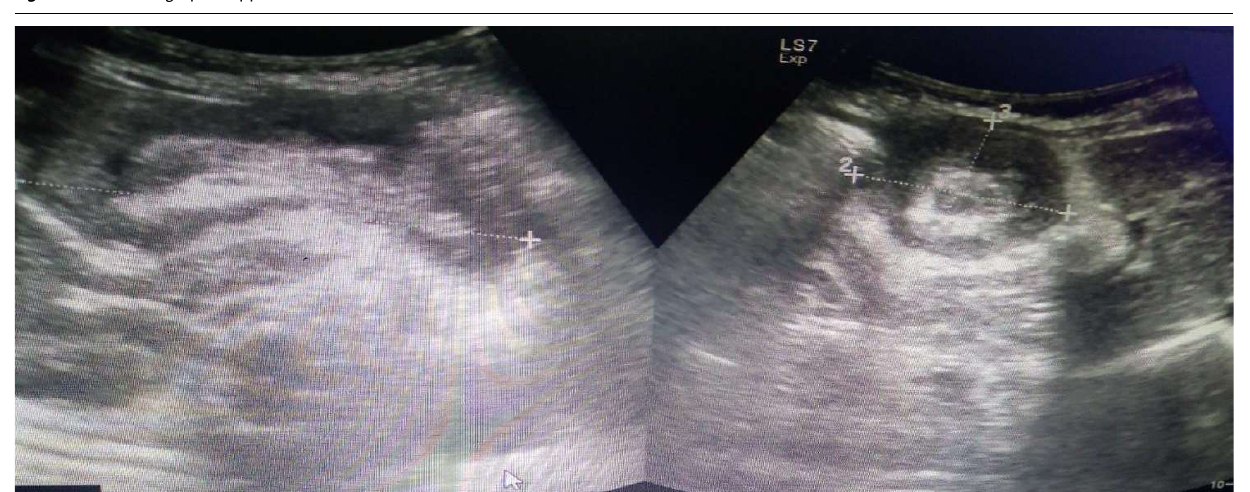
Figure 1. Ultrasonographic appearance of the abdomen of the child